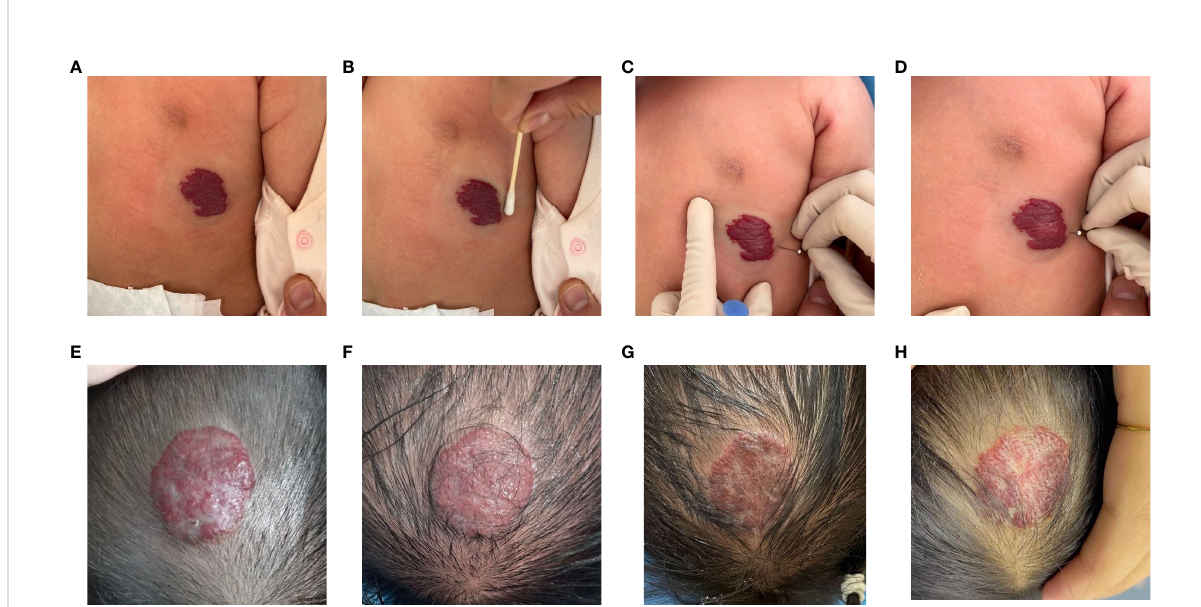
FIGURE 1 The procedure of intralesional injection (A – D) and a 4-month-old girl with a head hemangioma received intralesional injection (E – H) . (A) Baseline prior to initiation of intralesional injection. (B) Disinfection of the surface and perimeter of the lesion. (C) Needle is inserted through the normal tissue surrounding the lesion and punctured the middle layer of the lesion. (D) Suction before pushing the drug and then injecting the drug slowly until the surface of the tumor was slightly white,if there was no blood back fl ow. (E) Mixed infantile hemangioma of the head before the fi rst injection. (F) First course of injections. (G) Second course of injections. (H) Third course of